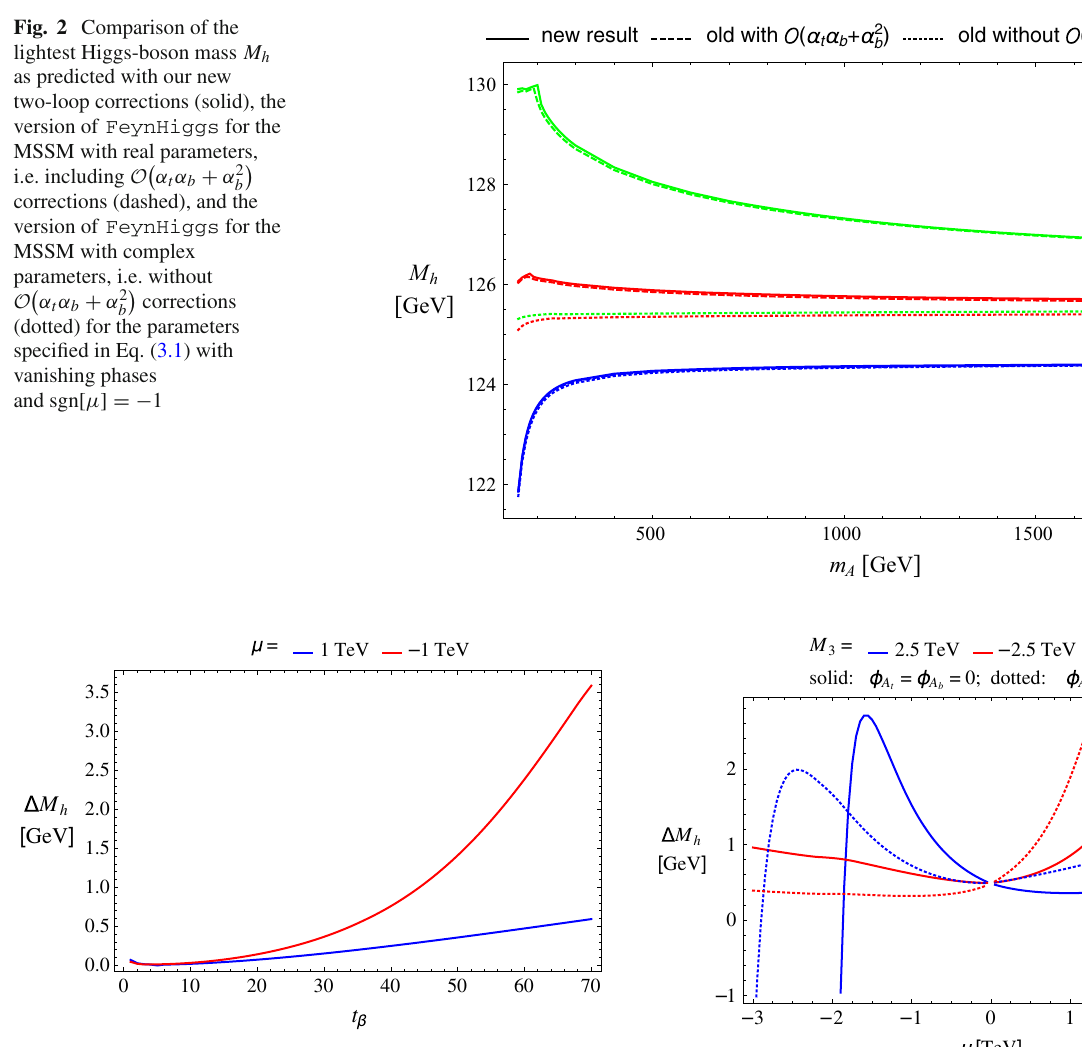
Fig. 3 Dependence of the lightest Higgs-mass shift (cid:7) M h on t β . The parameter μ is either positive (blue) or negative (red) Fig. 4 Dependence of the lightest Higgs-mass shift (cid:7) M h on μ . The parameter M 3 is either positive (blue) or negative (red). The region around μ = 0 is left out because of numerical instabilities mented in FeynHiggs so far employs further approxima- = tions of t β → ∞ and m b → 0 (see Ref. [39]), while our new result is not simplified further, the agreement is not expected to be perfect. The largest difference of ≈ 0 . 3GeV is found in − m ≈ 200GeV which the threshold region at m A = m ˜ ˜ t t 2 1 enters via the renormalization in the stop sector.